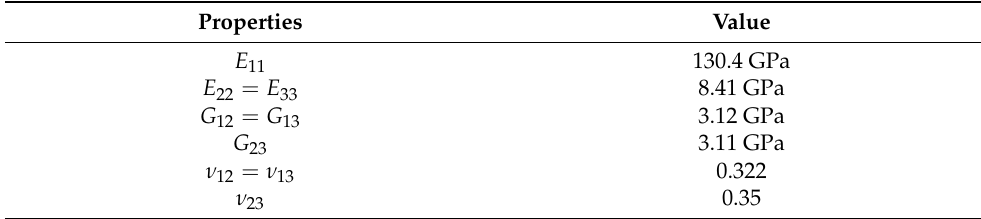
Figure 1. Photo of composite fan blade and FE model: ( a ) Composite fan blade; ( b ) FE model; ( c ) Boundary conditions.